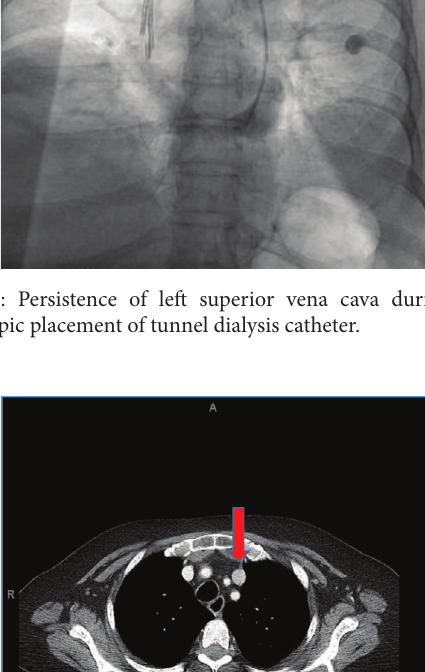
imaging (MRI) of abdomen which were conducted as part of outpatient workup for liver transplantation corroborated the existence of both PLSVC and HSK (Figure 2).